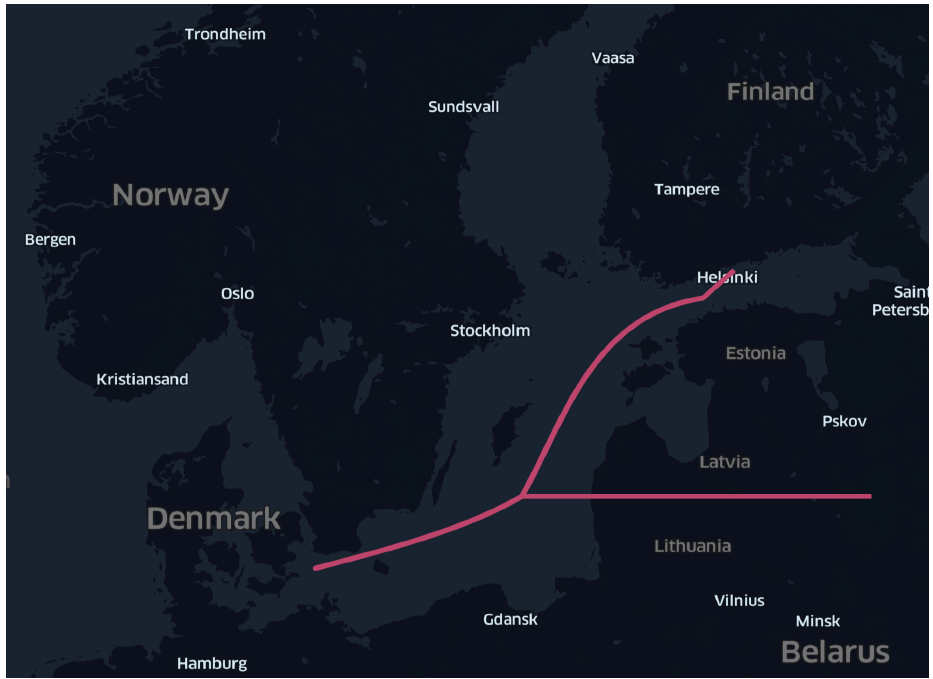
Figure 12. An example of invalid trajectory due to GPS